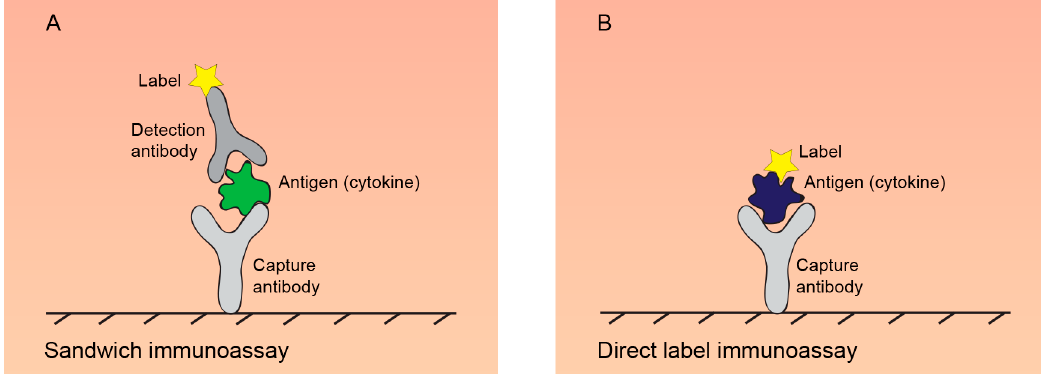
Figure 2. Principles of common immunoassays. ( A ) Sandwich immunoassays use matched pair of capture and detection antibody. Capture antibody is immobilized on a solid support, such as in 96-well plate, on beads, glass or a membrane array. Detection antibody conjugated to an enzyme, fluorescent tag or DNA tag, enables the quantification of cytokine; ( B ) in direct label assays, the proteins in analysed sample are labelled by fluorescent tags and incubated with an array of antibodies.